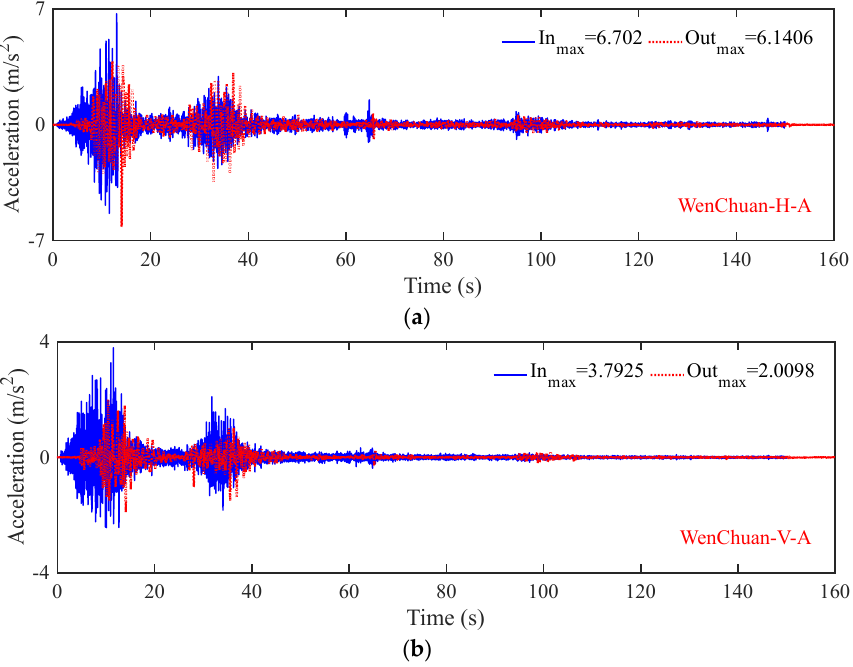
Figure 6. Comparison of the input and output seismic waveforms of centrifuge shaking table. ( a ) Horizontal. ( b ) Vertical.